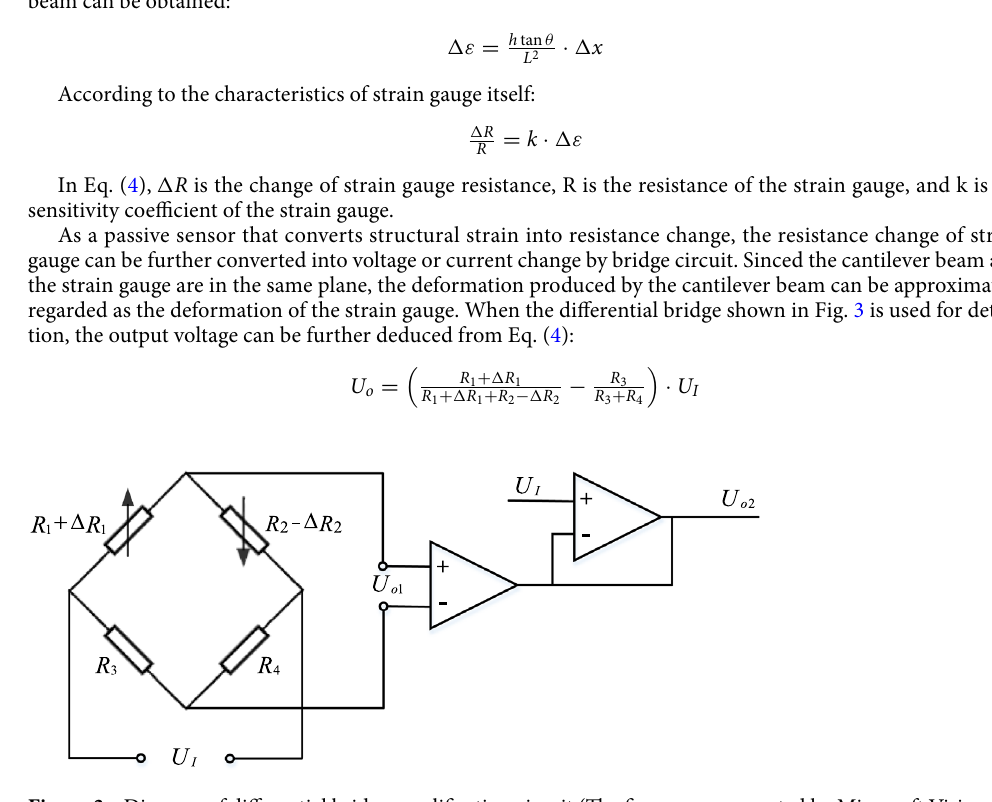
Figure 3. Diagram of differential bridge amplification circuit (The figure was generated by Microsoft Visio Professional 2016 (https:// www. micro soft. com/ zh- CN/ downl oad/ detai ls. aspx? id=